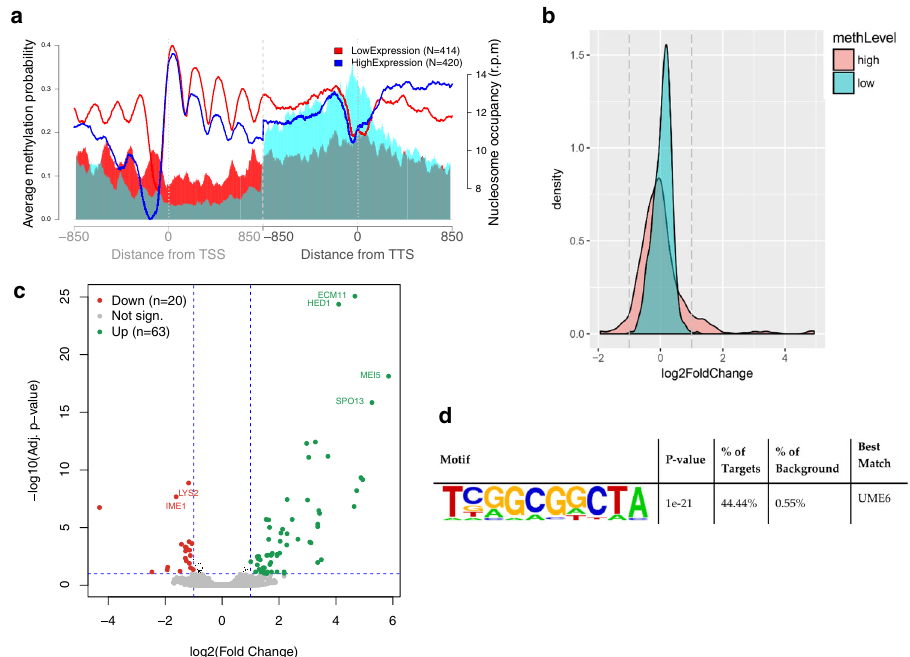
Fig. 5 Correlation of DNA methylation, nucleosome positioning and gene expression. a Methylation probability (shaded area) and nucleosome coverage (solid lines) around genes with expression in the top 10% (blue) or bottom 10% (red) expression level. b Log2 of the fold change in expression for genes with highly and lowly methylated promoters. c Gene expression difference between methylated and not methylated samples. RNA level difference is plotted on the x-axis and the Adj. p value on the y-axis. Downregulated (20 genes) and upregulated (63 genes) genes are shown in red and green, respectively. The genes with the highest changes are highlighted. d Promoter motif enrichment for genes with highly methylated promoters and increase in expression level using HOMER which uses a cumulative hypergeometric distribution to score motif enrichment in the target set compared to the background set. The p-value is not corrected for multiple